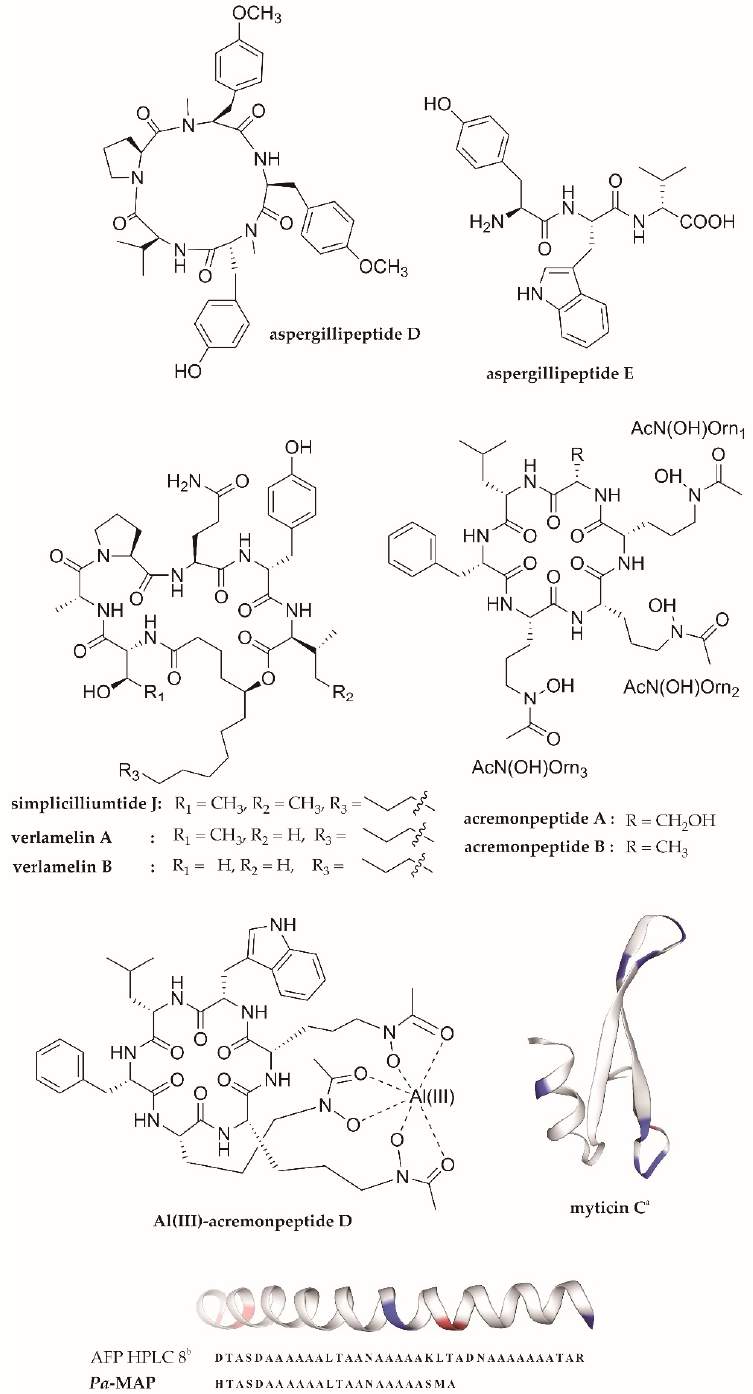
Figure 4. The structures of marine peptides demonstrating anti-HSV activity: a The structure of myticin C was generated using SWISS-MODEL modelling (https://swissmodel.expasy.org, accessed on 23 February 2022) [110,111], based on the amino acid sequence from GenBank with accession number AEZ79080.1 [112]. Moreover, the synthetic Pa -MAP is derived from the antifreeze peptide (AFP) HPLC-8 b (as shown by the amino acid sequence), the structural model of which was retrieved from the SWISS-MODEL repository (https://swissmodel.expasy.org/repository, accessed on 23 February 2022) [113], with the UniProtKB AC number Q99013 (ANPB_ PSEAM) [114]. The blue and red colors within the structural model indicate positively and negatively charged residues,